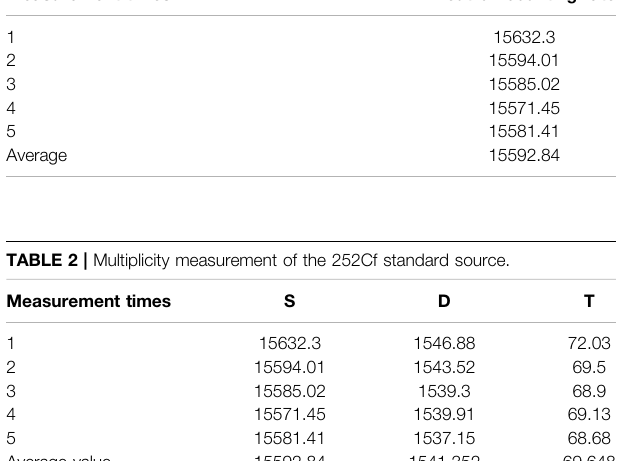
TABLE 1 | Measurement result of the 252Cf standard source. Measurement times